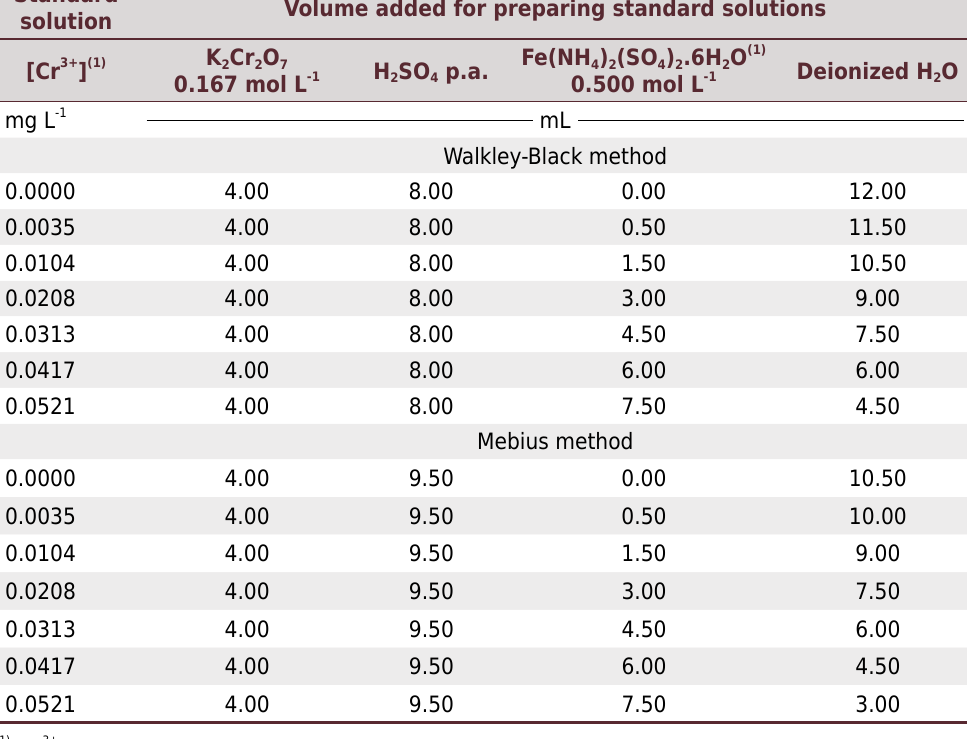
Table 2. Preparation conditions of standard solutions used in the calibration curve of the spectrophotometric method alternative to the Walkley-Black and Mebius method